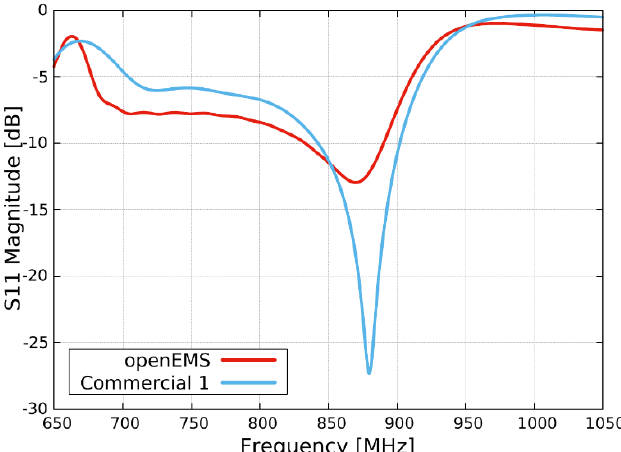
Fig. 4. Reflection coefficient of the three-element printed log-periodic antenna [33]. Red line: OpenEMS; Blue line: commercial code